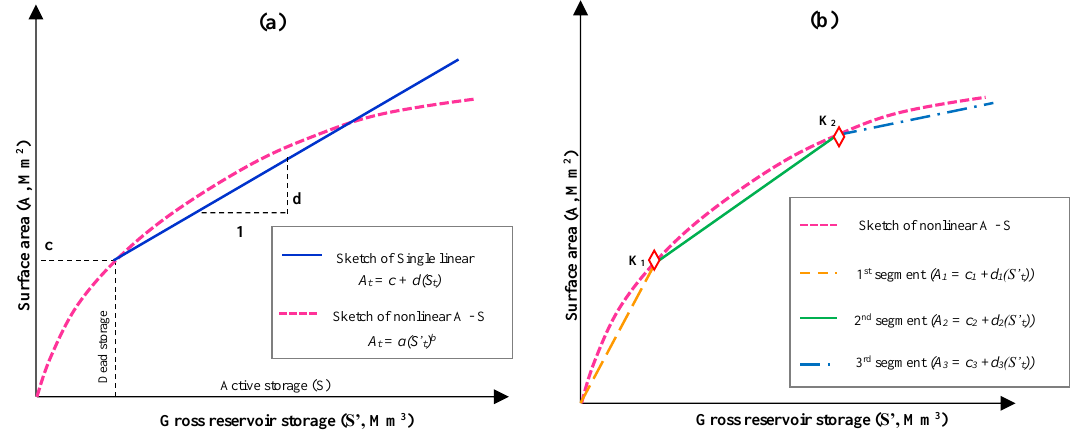
Figure 1. Sketch illustration of ( a ) single linear and ( b ) 3-piecewise linear approximations.